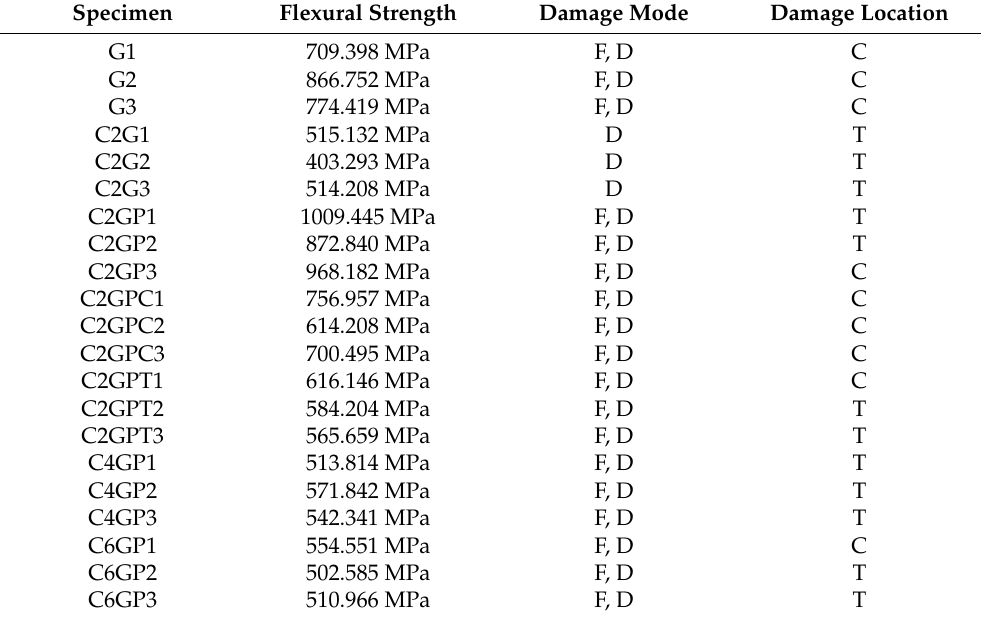
Figure 8. Schematic of resin accumulation inside the self-sensing composite laminate. Table 1. Flexural strength, damage mode, and location of damaged